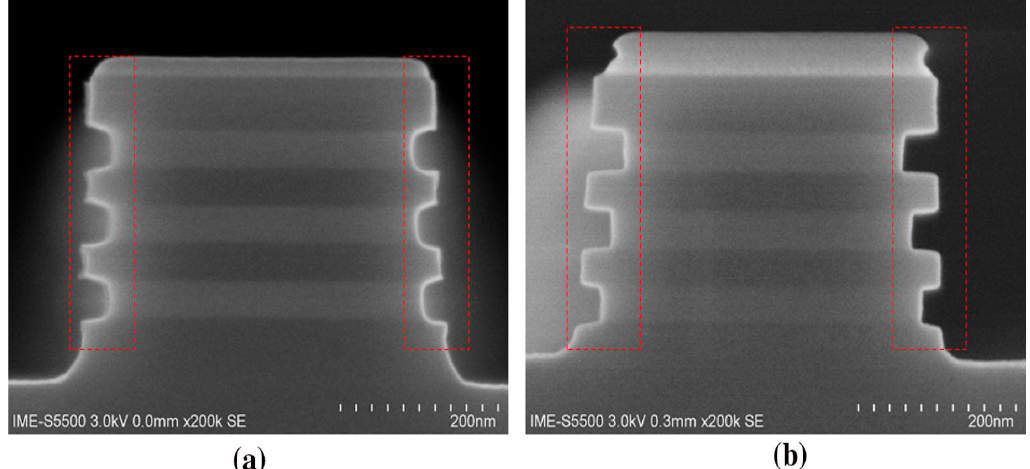
Figure 34. The SEM images of cross section comparing the profile between wet etching and inductively coupled plasma (ICP) dry etching: ( a ) Wet etching SiGe with 6% HF/30% H 2 O 2/ 99.8% CH 3 COOH = 1:2:4 etching 8 min, and ( b ) ICP dry etching SiGe with CF 4 /O 2 /He = 4:1:5 [207].